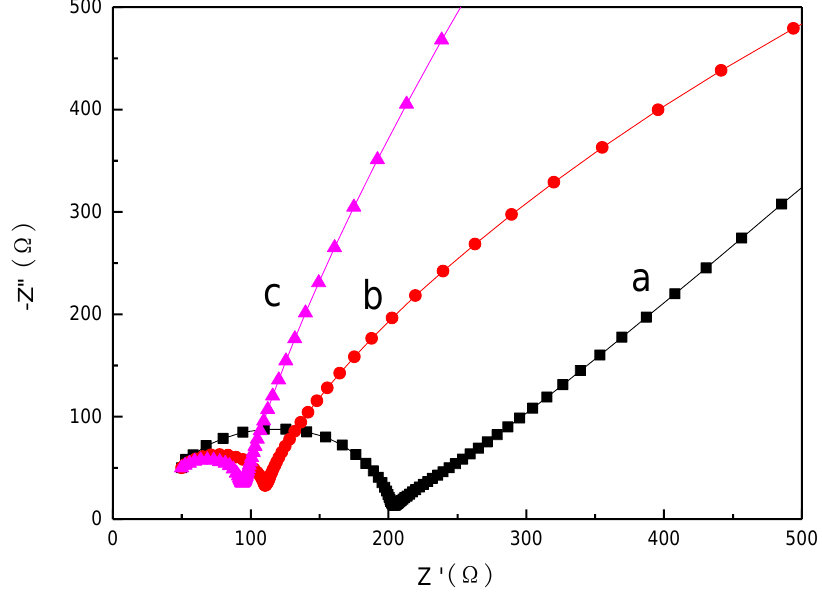
Figure 8. Electrochemical impedance spectra of ZnS ( a ), Al-ZnS ( b ) and Al-ZG1.2 ( c ).